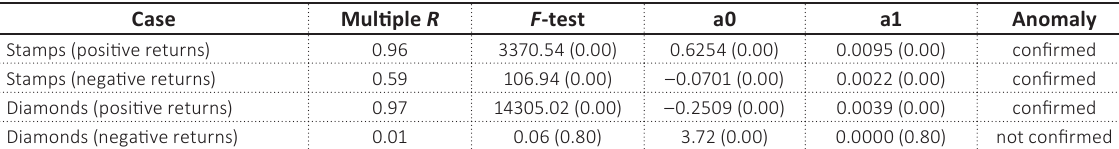
Table A6. Modified CAR